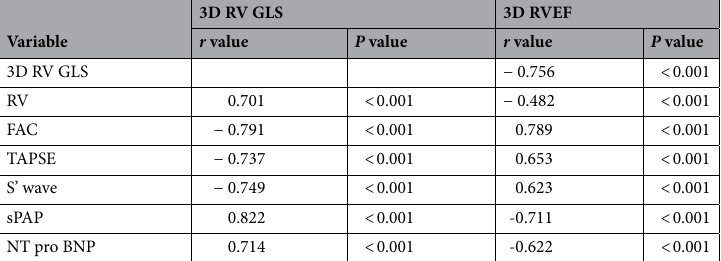
Table 2. Correlations of 3D RV GLS and 3D RVEF with conventional RV function parameters and NT pro BNP. RV right ventricle, TAPSE tricuspid annular plane systolic excursion, sPAP pulmonary artery systolic pressure, FAC fractional area change, 3D RVEF three dimensional right ventricle ejection fraction, GLS global longitudinal strain, S ′ wave: systolic wave prime; NT-pro BNP